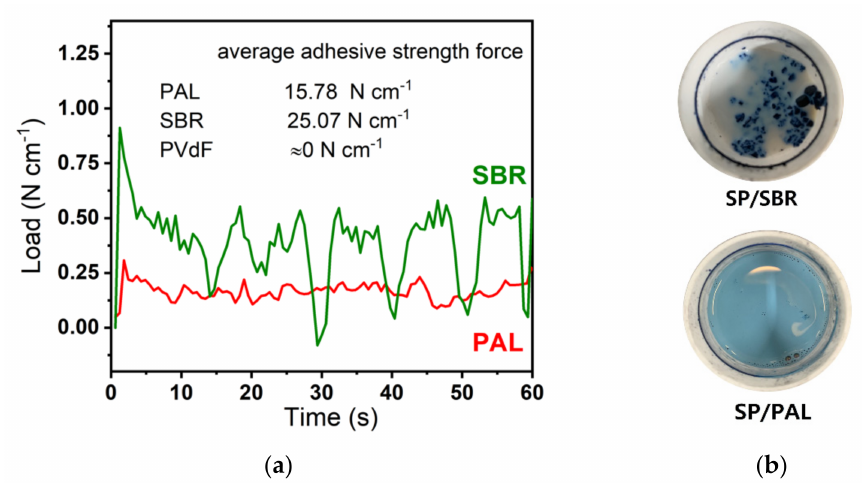
Figure 3. ( a ) 180 ◦ peel strength of LiFePO 4 (LFP) electrodes containing PAL, SBR, or PVdF binder. ( b ) Dispersion of SP in PAL and SBR latices. Table 1. Surface and volume resistivities and interface resistance of the LFP electrodes.